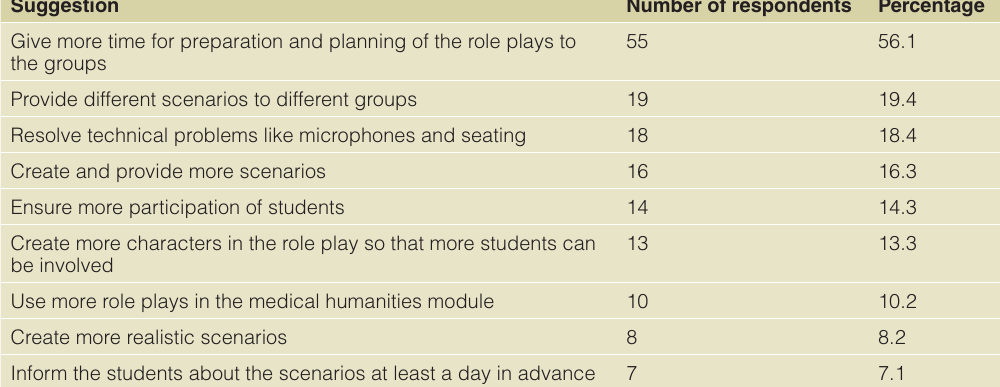
Table 3. Suggestions of respondents to further improve use of role plays in